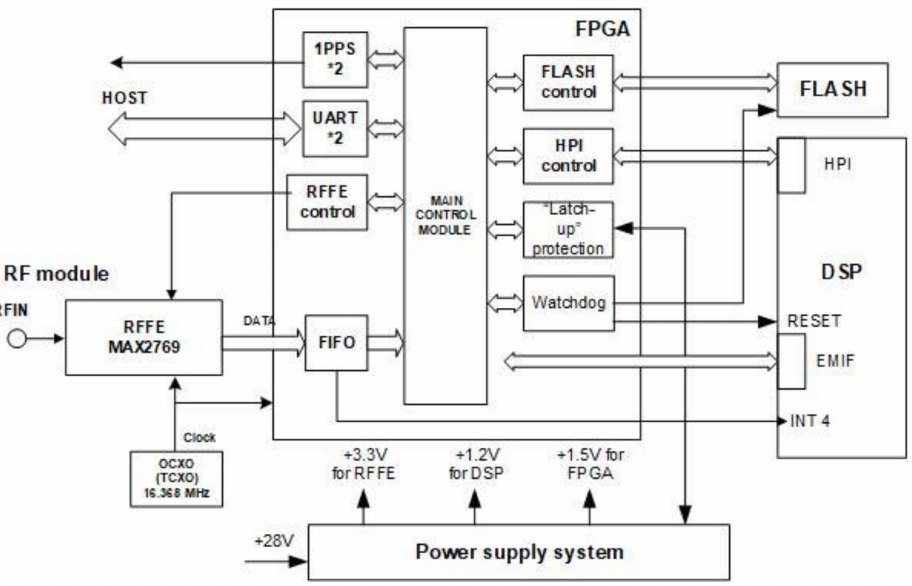
Figure 5. The National Space Organization (NSPO) GPS receiver (GPSR) block